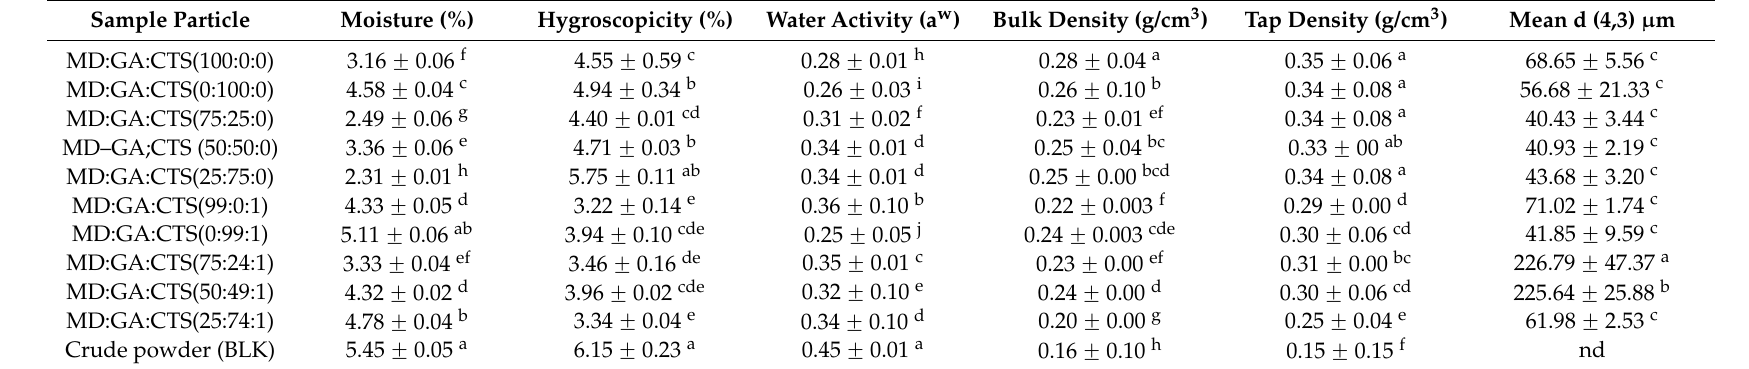
Table 1. Physicochemical properties of spray-dried green tea